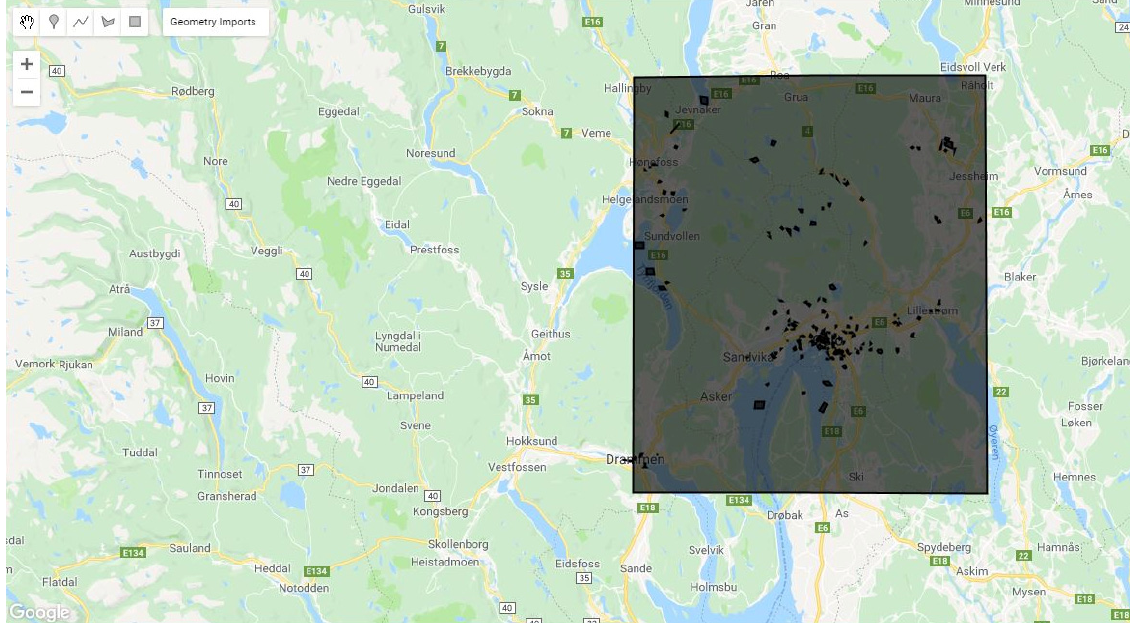
Figure 8. Import of ROI and TA shapefiles to Google Earth Engine.